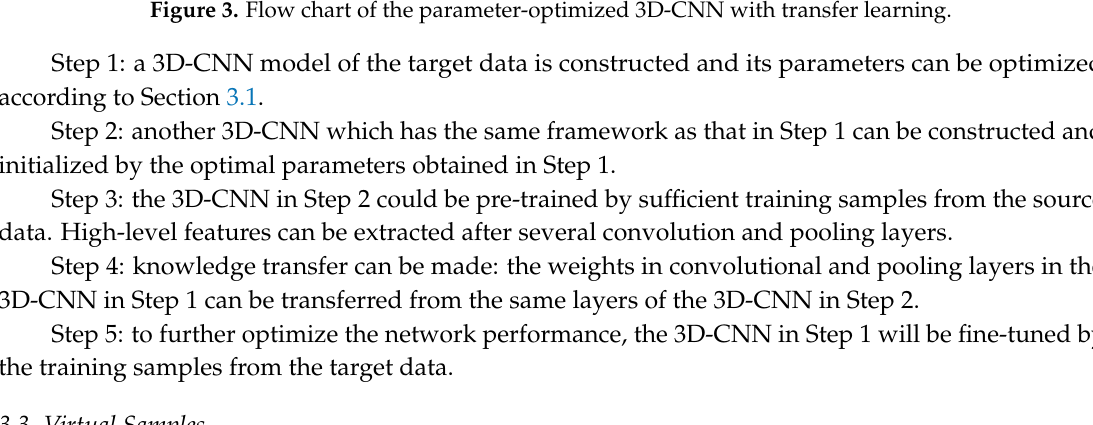
Figure 3. Flow chart of the parameter-optimized 3D-CNN with transfer learning.